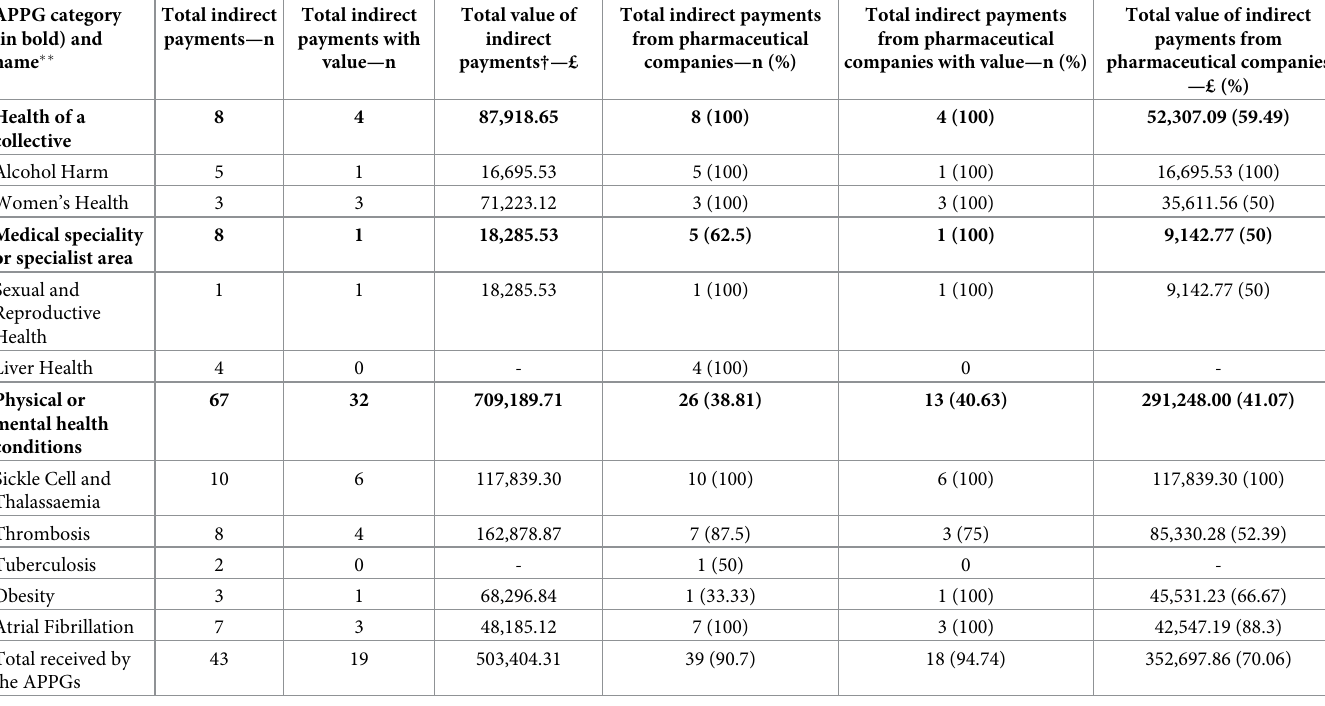
Table 3. Total number and value of indirect payments from pharmaceutical companies as a proportion of all indirect payments (2012–2018). APPG category (in bold) and